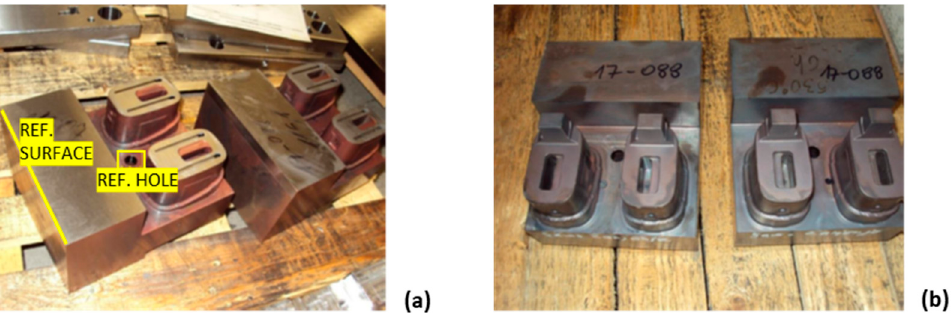
Figure 12. Tool core base after hardening with reference features for SLM ( a ), all four tool cores prepared for hardening after completed SLM upgrade ( b